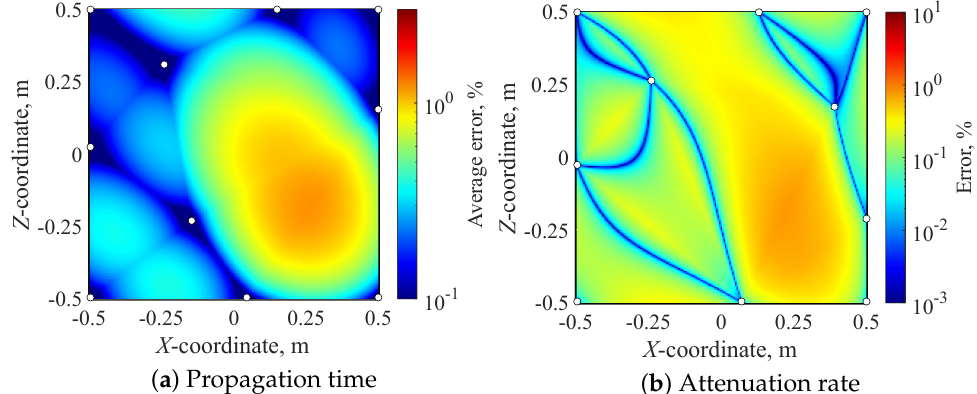
Figure 11. Distributions of error in the sound source grid estimated by TIN interpolation ( p = r , 10 sampling